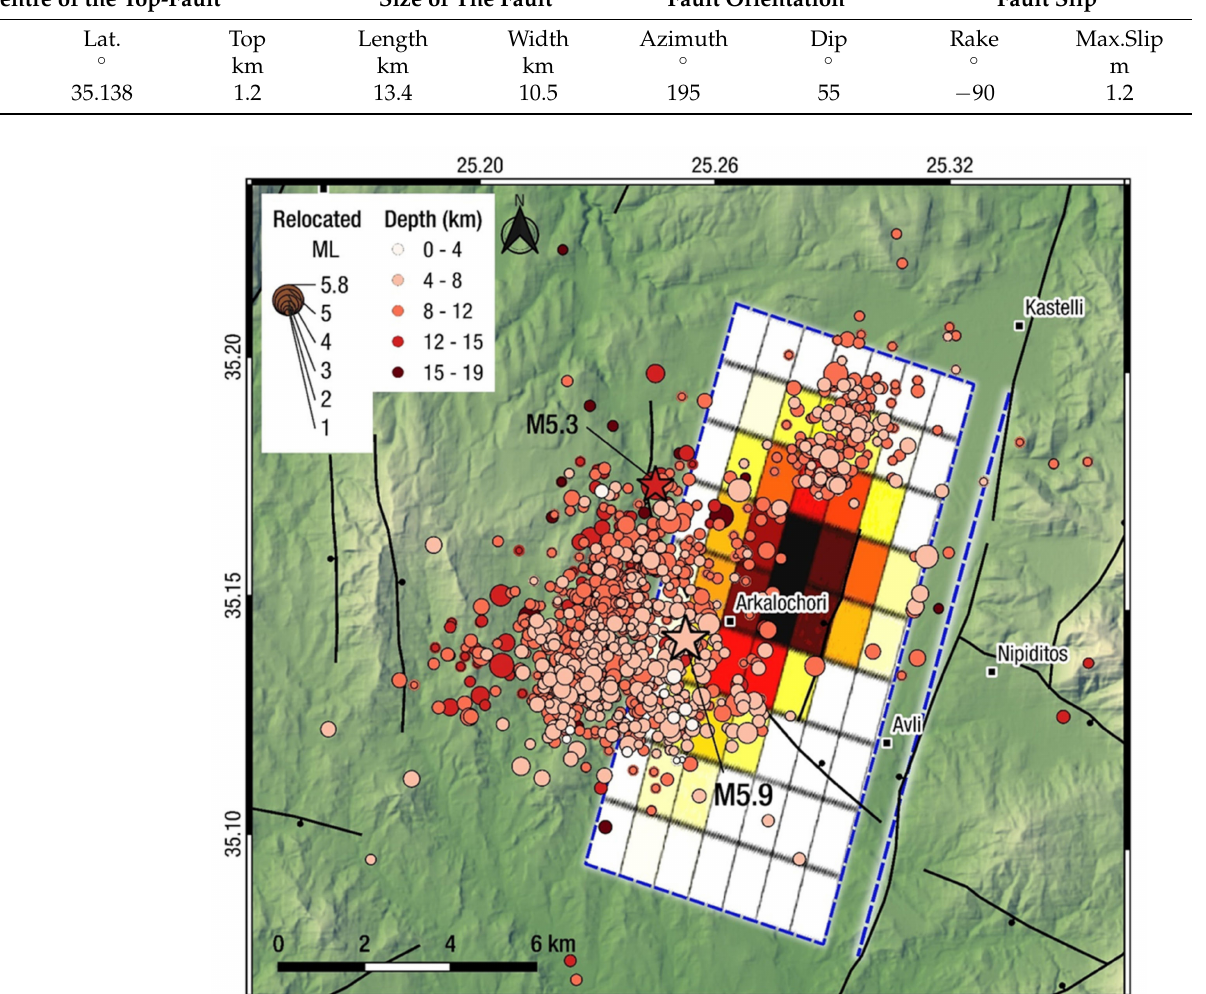
Figure 9. Relief map showing aftershock distribution and the surface projection of the modelled fault plane (coloured rectangle). Note that the aftershocks are distributed around the main asperity (coloured squares; see Figure 8 for fault model). Also note that the aftershock depth increases toward the west, in the vicinity of the epicentre (up to 4 km in map view). The dashed blue line indicates the projected intersection of the modelled fault plane with the Earth’s